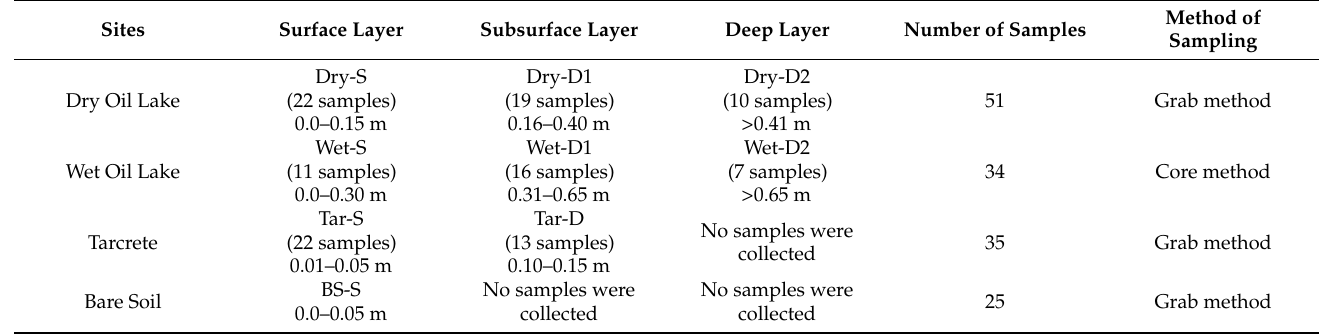
Table 2. List of analyzed parameters for collected soil Table 1. Number of samples, sampling methods, and sampling depth for the different categories of contaminated sites.